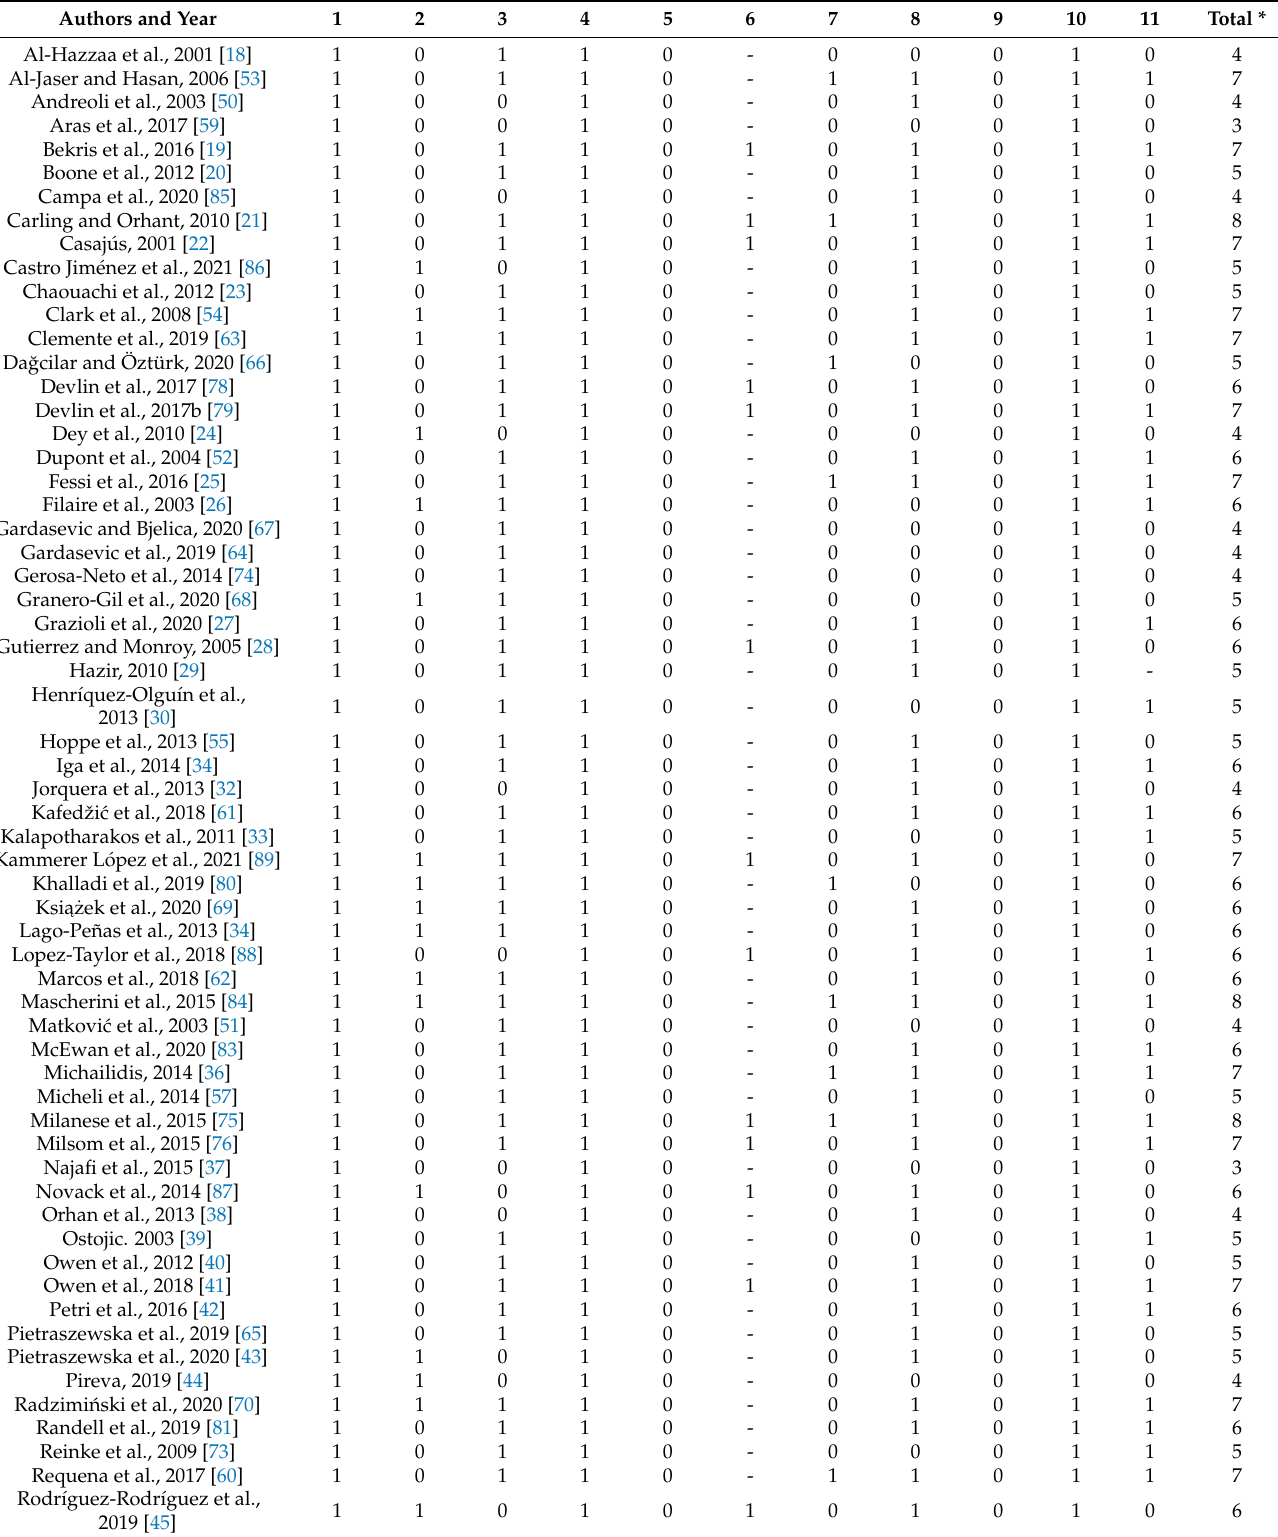
Table 5. Analysis of methodological quality according to the Agency for Health Research and Quality (AHRQ) Methodology